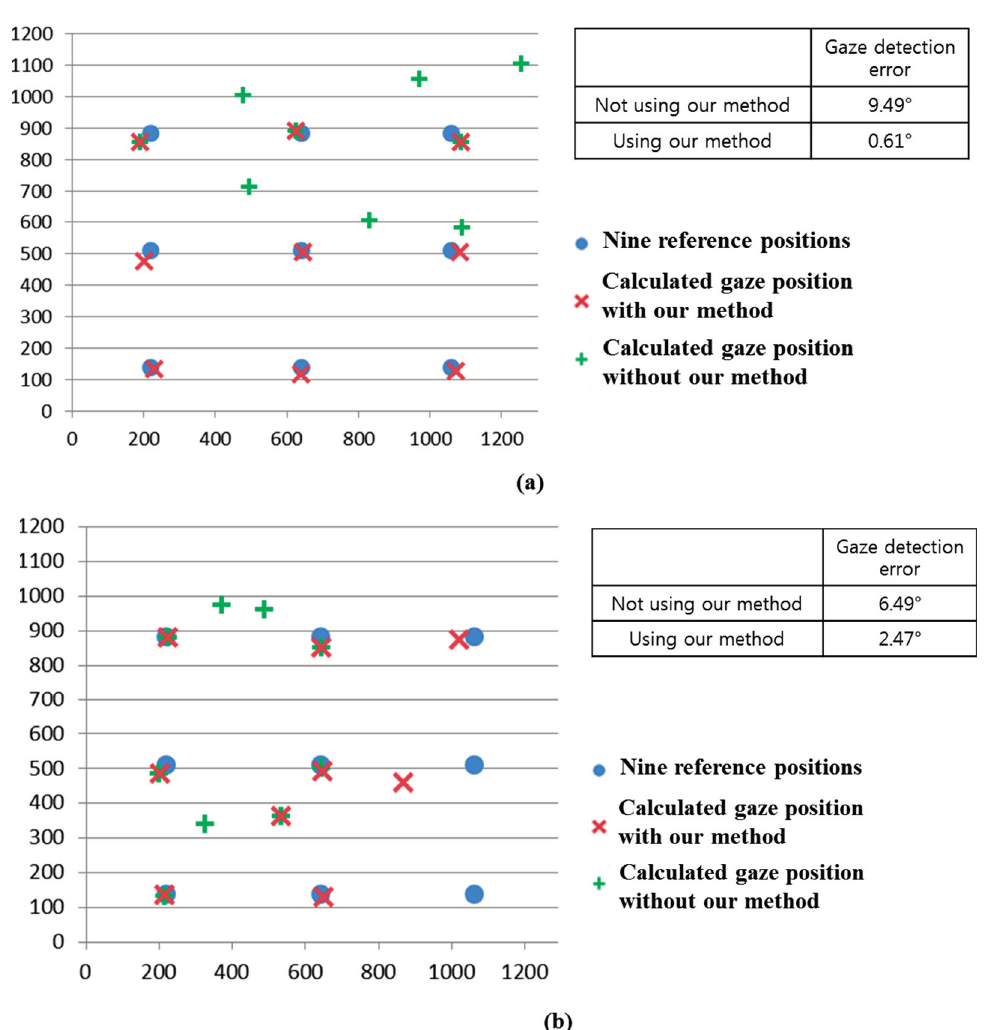
Figure 25. Result images where the pupil and SR are correctly detected in the presence of the halogen lamp at various positions ( a ) above monitor display ( b ) right of monitor display ( c ) below monitor display ( d ) left of monitor